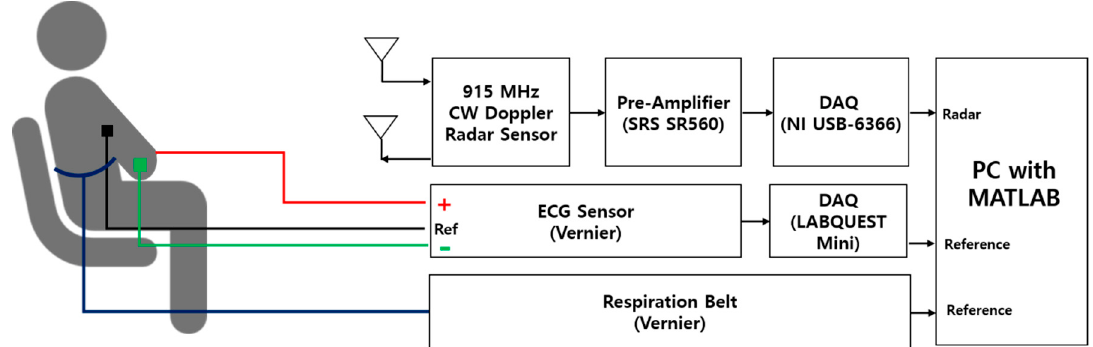
Figure 9. Measurement setup for vital-sign detection using the 915 MHz radar and the reference electrocardiogram (ECG)